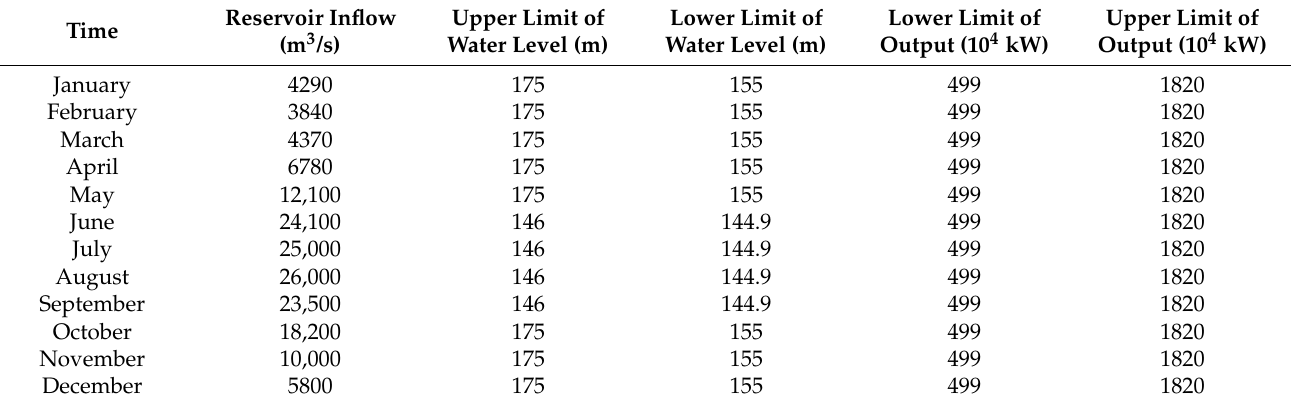
Table 2. Constraint conditions for optimal scheduling scheme for the TG